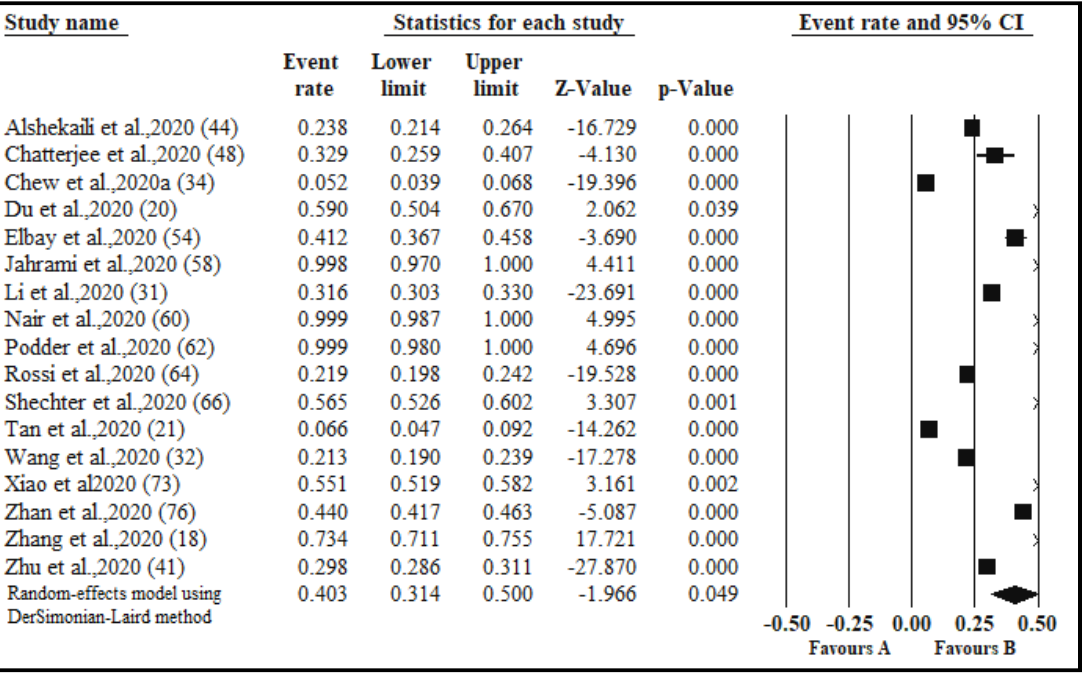
Figure 4. Forest plot for the studies on the prevalence of stress among healthcare workers. The squares and horizontal lines correspond to the study-specific event (anxiety) rates and 95% confidence intervals (CIs). The diamond represents the pooled prevalence and 95% CIs of the overall population. The overall pooled stress using a random effects DerSimonian-Laird method was 40.3% (95% CI 31.4–50.0).